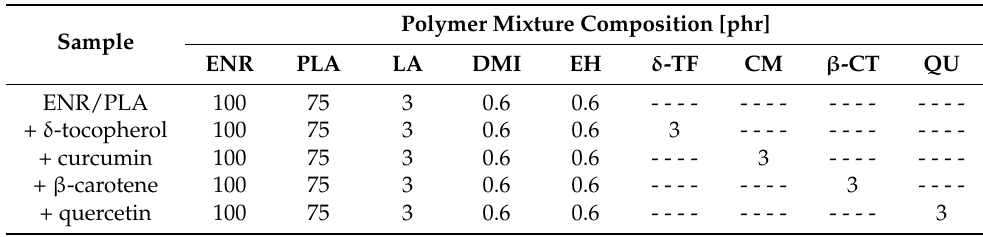
Table 1. Composition of the polymer blend mixtures prepared for analysis in this research. Ab- breviations: ENR—epoxidized natural rubber, PLA—poly(lactic acid), LA—lauric acid, DMI— 1,2-dimethylimidazole, EH—elastin hydrolysate, δ -TF— δ -tocopherol, CM—curcumin, β -CT— β - carotene, QU—quercetin, phr—per hundred rubber (it means: for one hundred parts by weight